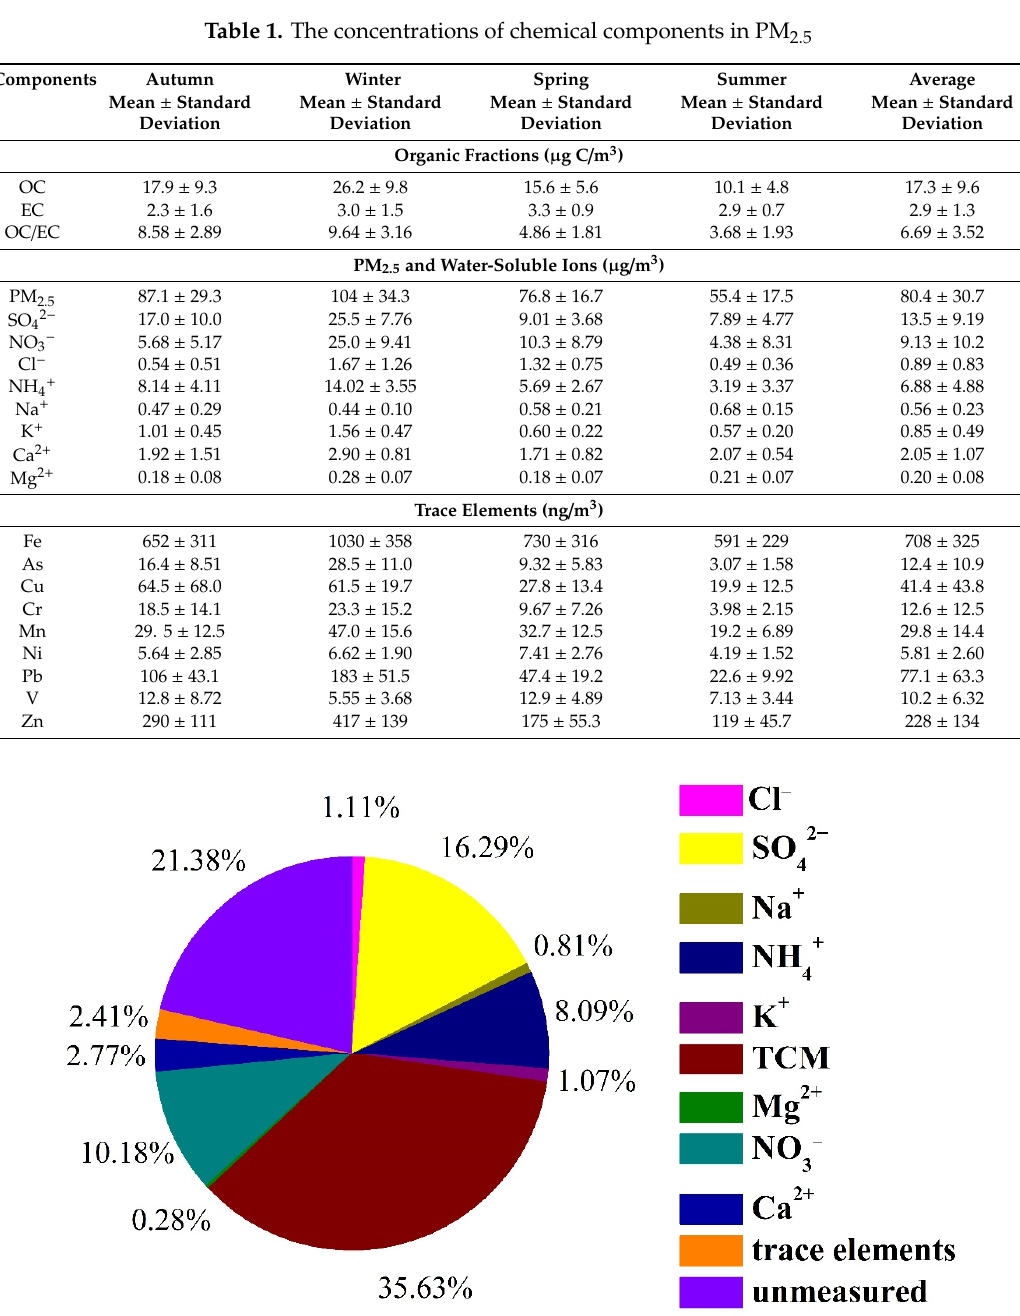
Figure 1. Contributions of chemical components to PM 2.5 mass.